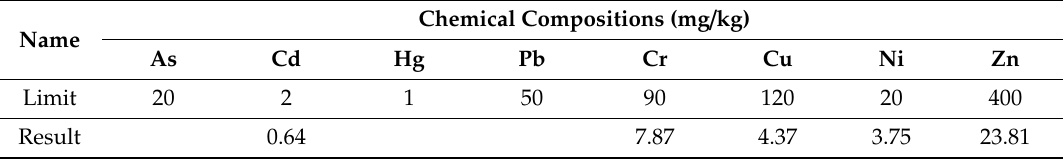
Table 4. Hazardous component test of natural zeolite.